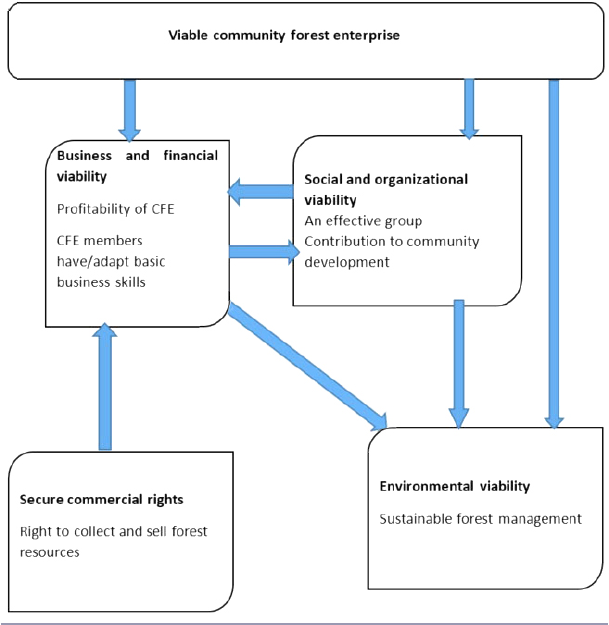
Fig. 1 . Analytical framework: community forest as viable